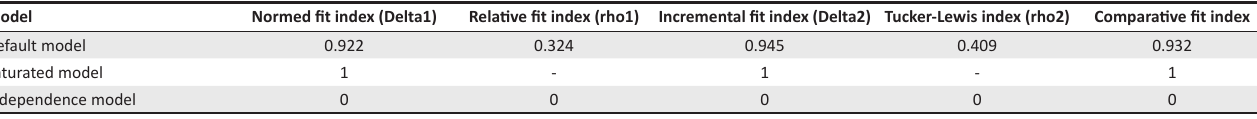
TABLE 6b: SEM model fit statistics. Model